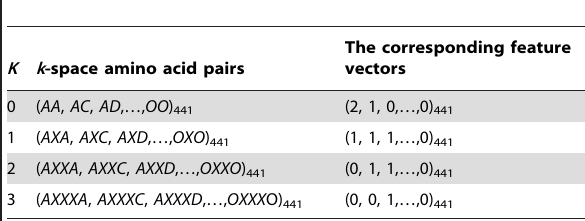
Table 1. An example of the CKSAAP encoding scheme with k = 0, 1, 2, 3 for sequence fragment